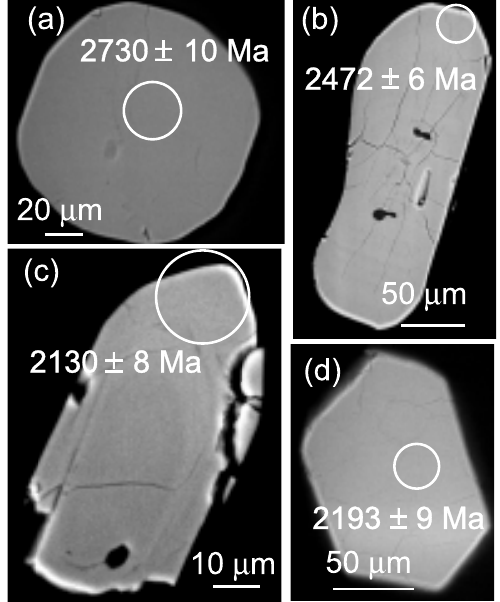
Fig. 2 – BSE images of zircon crystals from dated granulite, sample AL-1; SHRIMP spots indicated as white circles; ages of spots shown. (a) Soccer-ball M 1 zircon crystal, formed during Archean granulite facies event. (b) Rounded, elongated crystal; age is inter- preted as lead loss due to a younger event (2.2 Ga?). (c) M 2 + M 3 metamorphic events dated on rim and (d) core of subhedral crystal, interpreted as corresponding to amphibolite and recurrent granulite